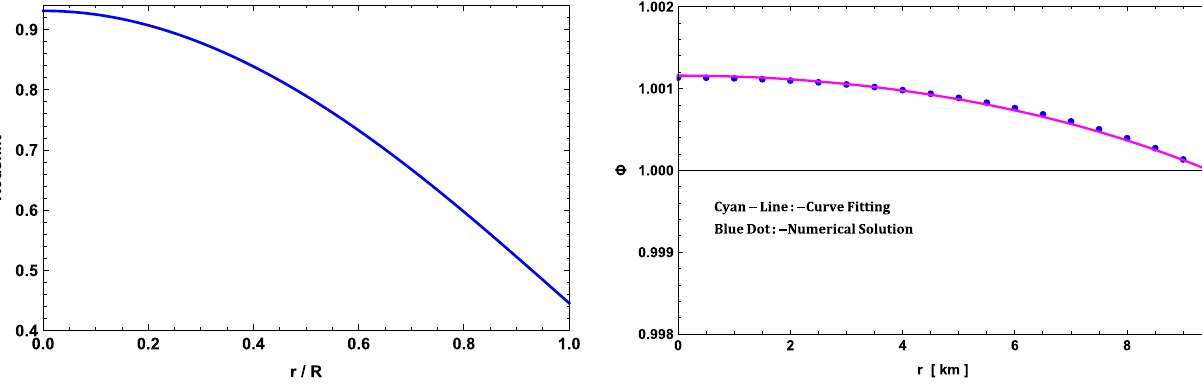
Fig. 7 The gravitational redshift profile and scalar field Φ( r ) are plotted against r / R by taking the same values as in Fig. 1 for PSR